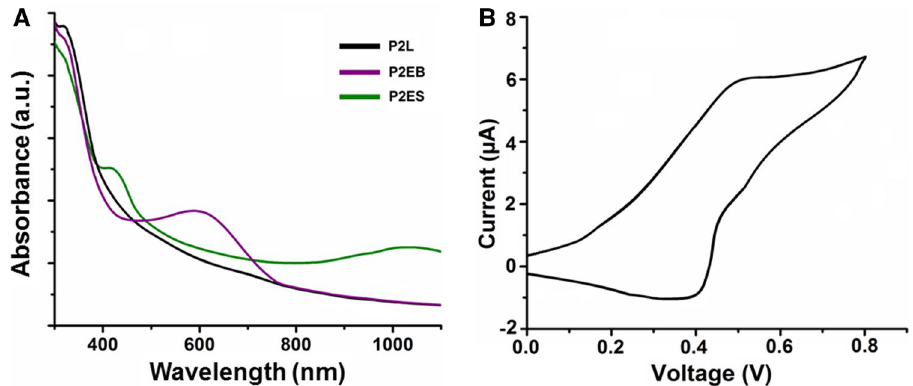
Figure 4. UV–Vis–NIR spectra of amphiphilic ABA type triblock copolymers ( A ), and cyclic voltammogram of P2L ( B ).